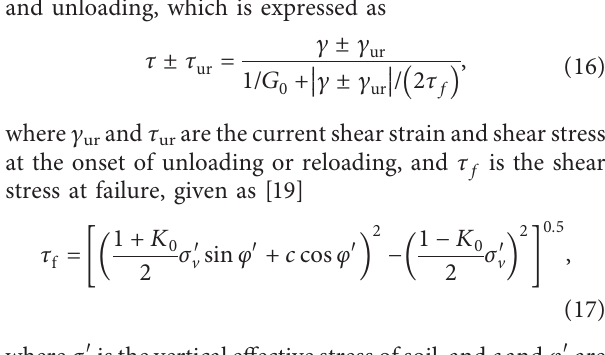
Figure 3: Illustration of scour-hole stress